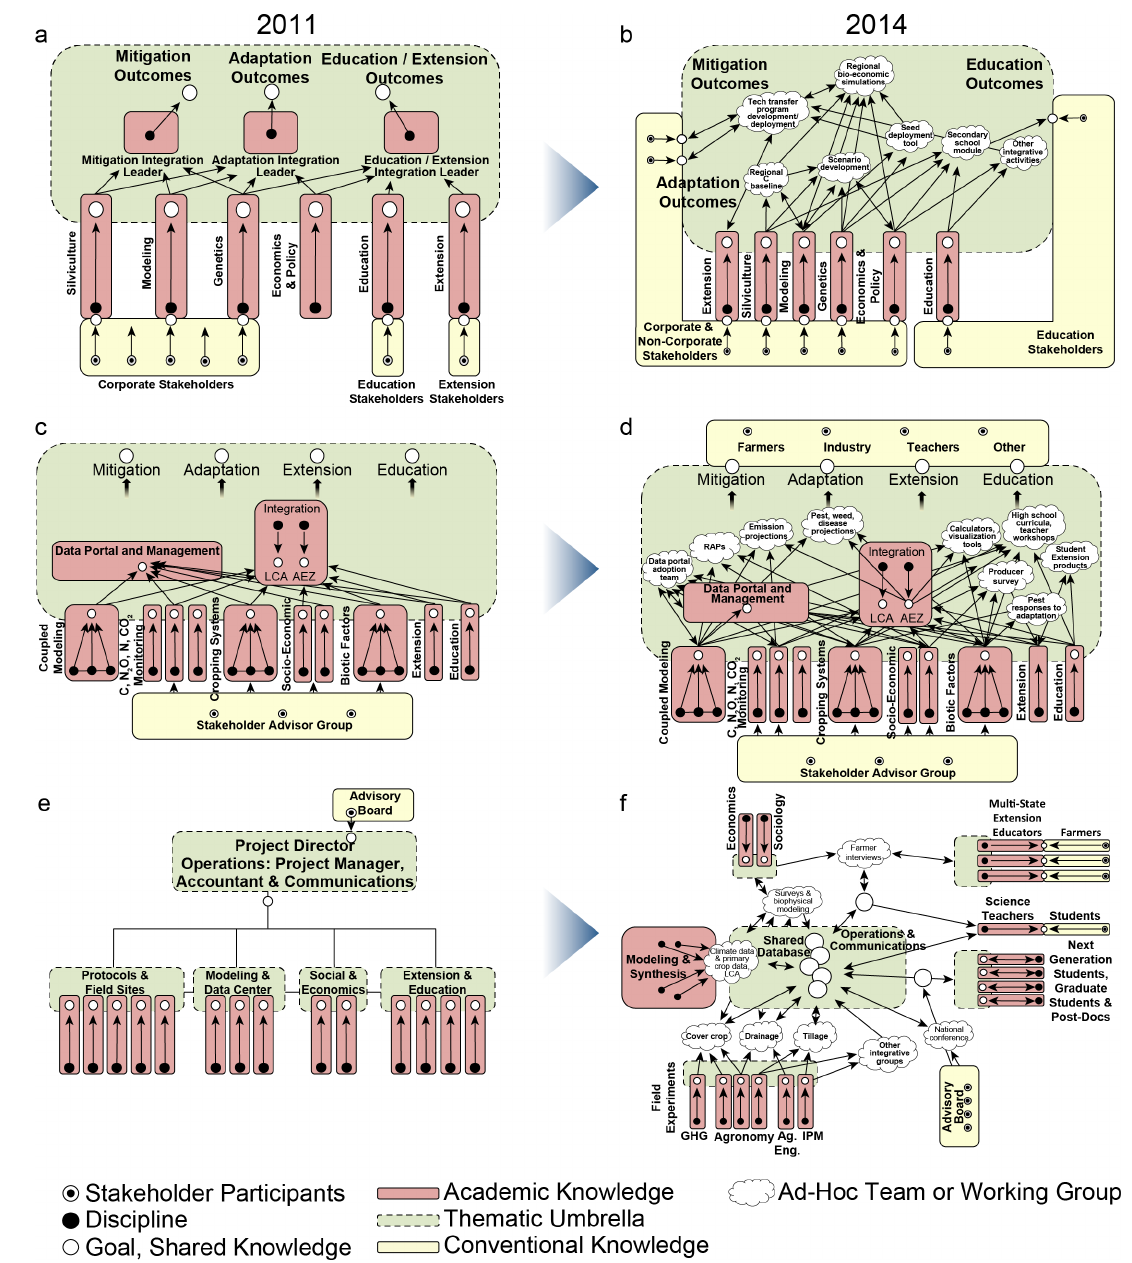
Fig. 2 . Graphical representation of the adaptive architectures of integration for three U.S. Department of Agriculture–National Institute of Food and Agriculture (USDA-NIFA) Coordinated Agricultural Projects. Panels a and b, Pine Integrated Network: Education, Mitigation and Adaptation Project (PINEMAP); panels c and d, Regional Approaches to Climate Change for Pacific Northwest Agriculture (REACCH-PNA); panels e and f, Cropping Systems Coordinated Agricultural Project: Climate Change, Mitigation, and Adaptation in Corn-based Cropping Systems (CSCAP). Illustrated are the collaborative structures of these projects at conception in spring 2011 and as of March 2014. Each project is visualized as a combination of disciplinary, multidisciplinary, participatory, and transdisciplinary effort. As the projects progress, their collaborative architectures become more complex, incorporating ad hoc teams or working groups to address emerging challenges and opportunities. These working groups are a mix of interdisciplinary or transdisciplinary efforts. Graphical conventions are as in Figure 1. AEZ indicates agroecological zone; LCA, life cycle